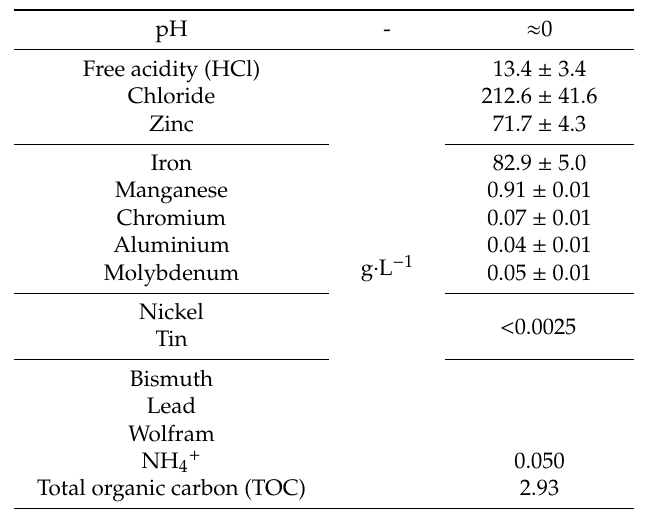
Table 3. Composition of spent pickling